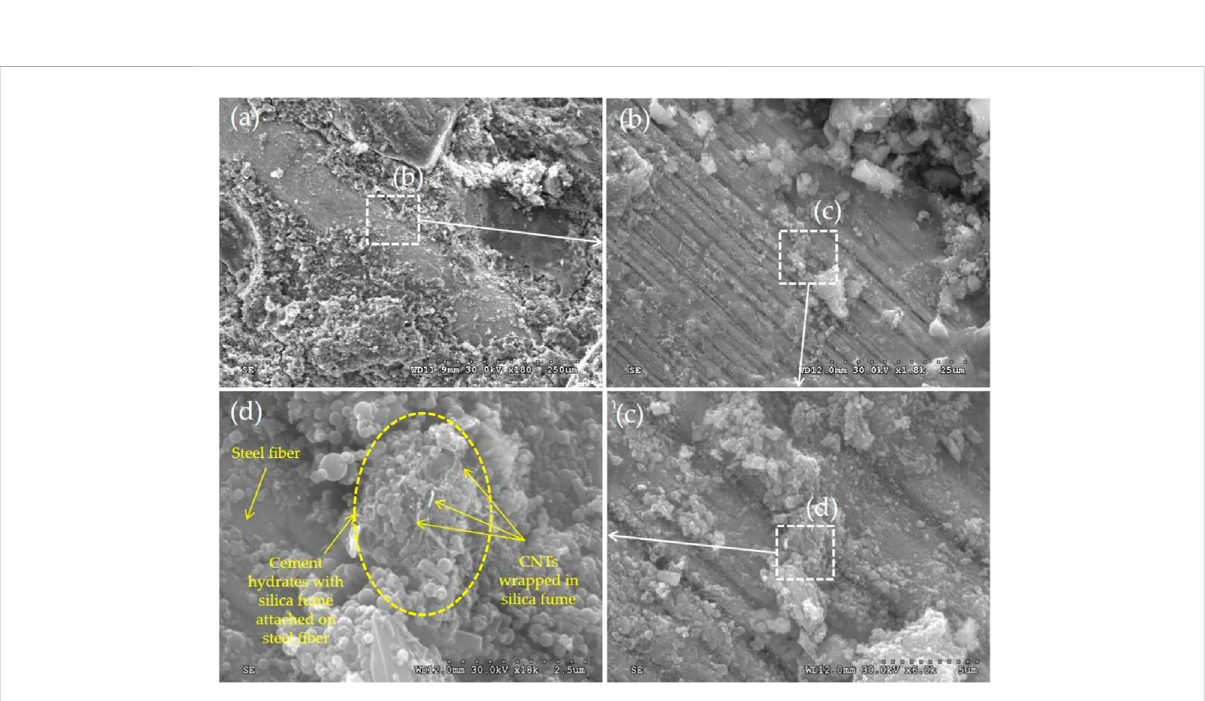
FIGURE 13 SEM images for steel fi ber-reinforced UHPC (taken from You et al. (2017)).